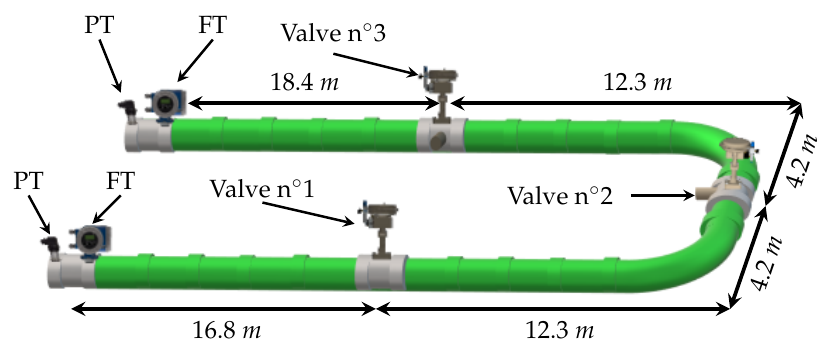
Figure 3. Schematic diagram of the pipeline’s